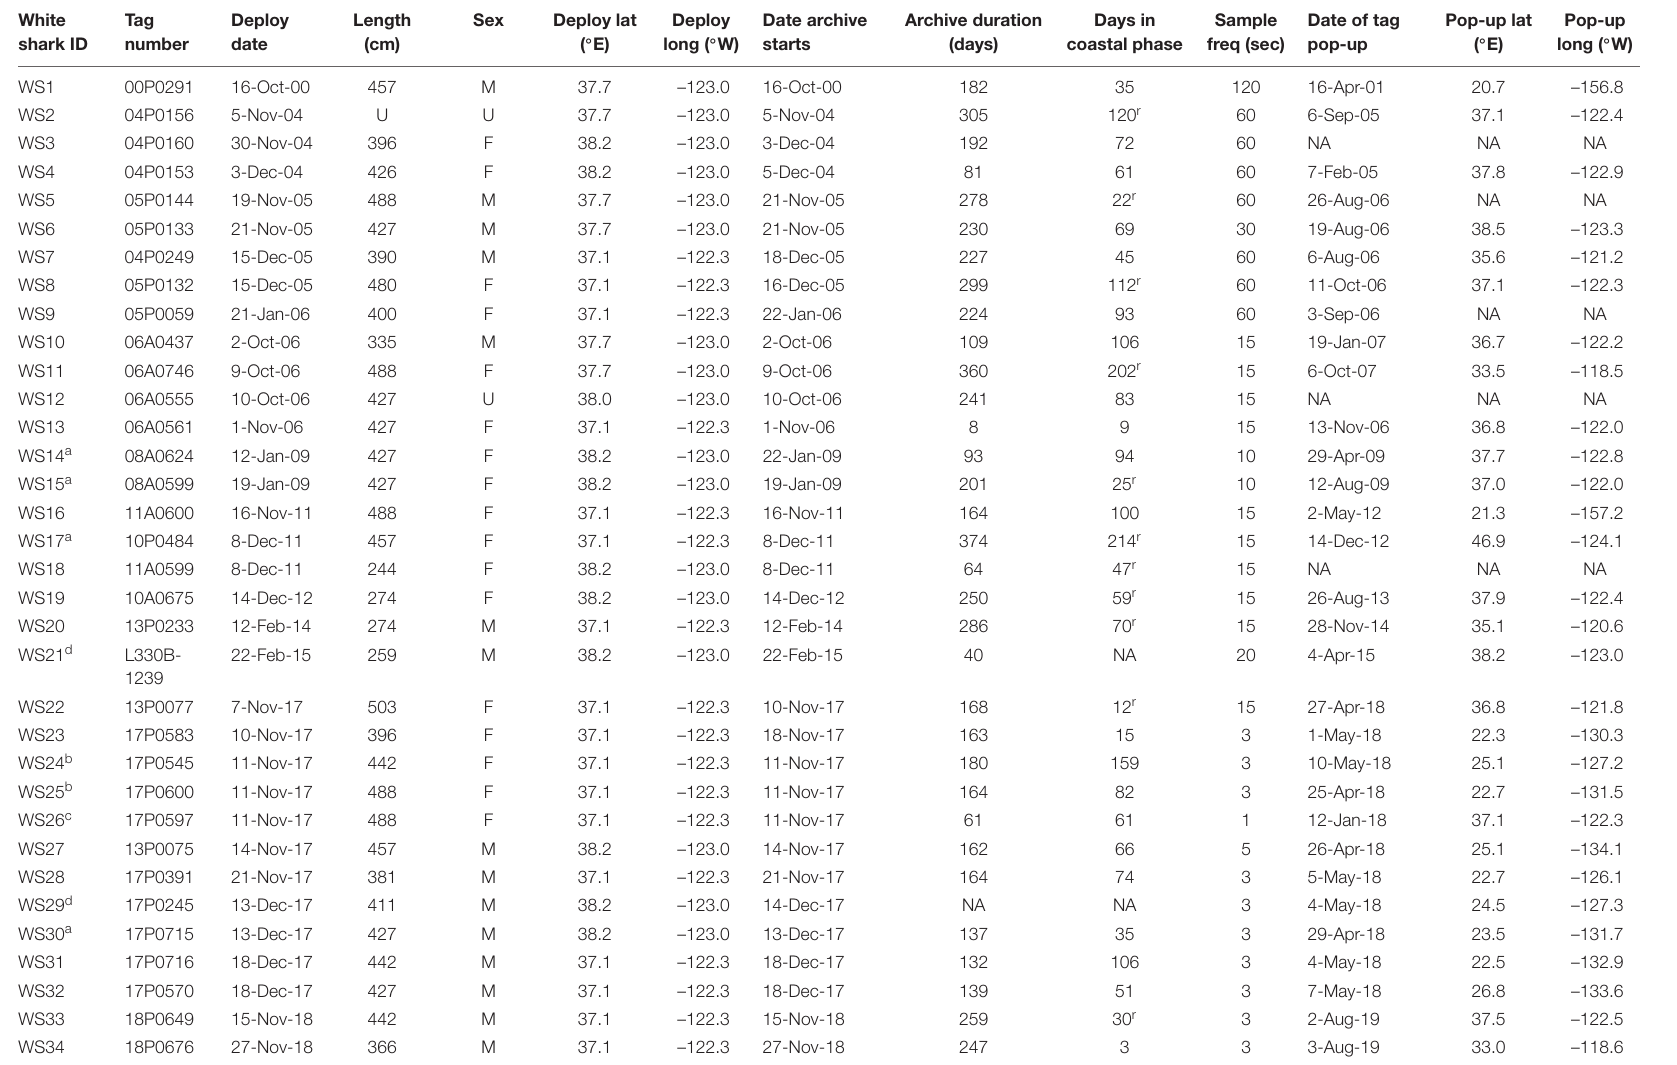
TABLE 1 | Recovered tag deployment details for white sharks tagged in northern California from 2000 to